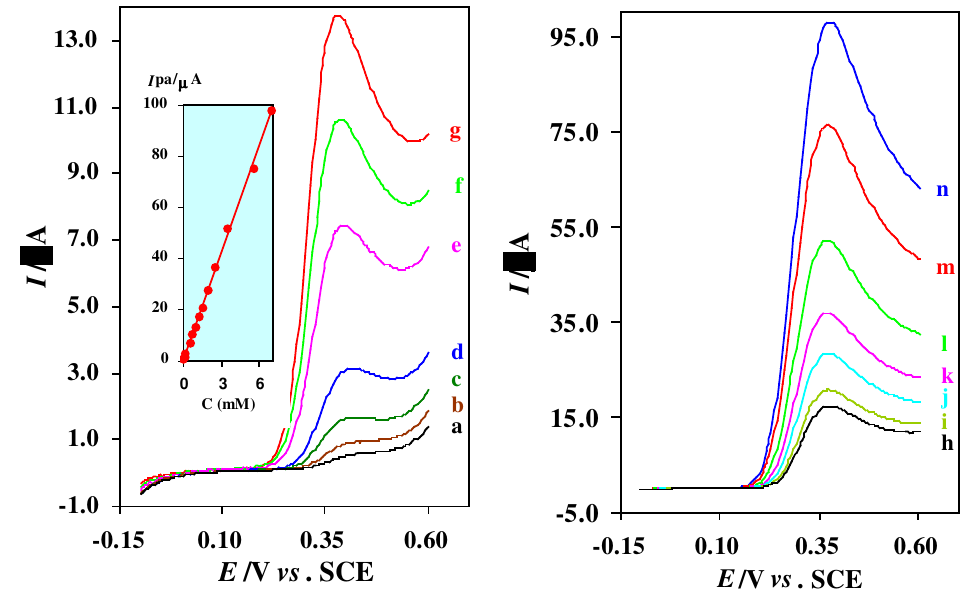
Figure 6. Linear sweep voltammograms of thiourea at alumina modified Pt electrode (2 mm diameter) in acetate buffer solution (C = 0.15 M, pH = 4.5). Thiourea concentrations from (a) to (n) are: 2.5 · 10 -5 , 5.0 · 10 -5 , 1.0 · 10 -4 , 2.0 · 10 -4 , 5.0 · 10 -4 , 7.5 · 10 -4 , 1.0 · 10 -3 ,